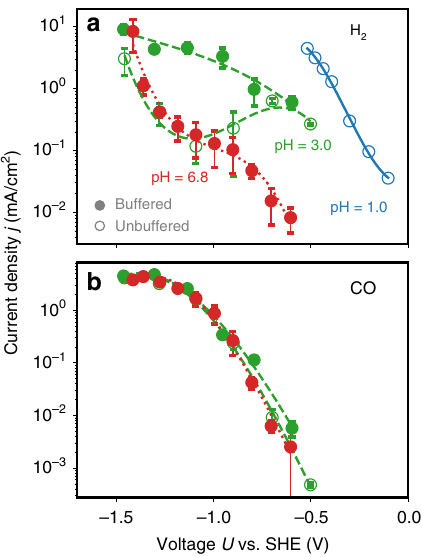
Fig. 2 Experimental CO 2 R polarization curves. a H 2 and b CO partial current density. The data was obtained from running CO a polycrystalline Gold electrode at various bulk pH conditions. The red, green and blue circles refer to bulk pH values of 6.8, 3.0 and 1.0, respectively. Filled circles denote buffered conditions using 0.1 M potassium bicarbonate (KHCO 3 , pH 6.8) and 0.1 M potassium phosphate (KH 2 PO 4 , pH 3.0), while the empty circles refer to unbuffered conditions using 0.1 M potassium perchlorate (KClO 4 , pH 3.0) and 0.1 M perchloric acid (HClO 4 , pH 1.0) as electrolytes. The vertical error bars represent the standard deviation resulting from three separate